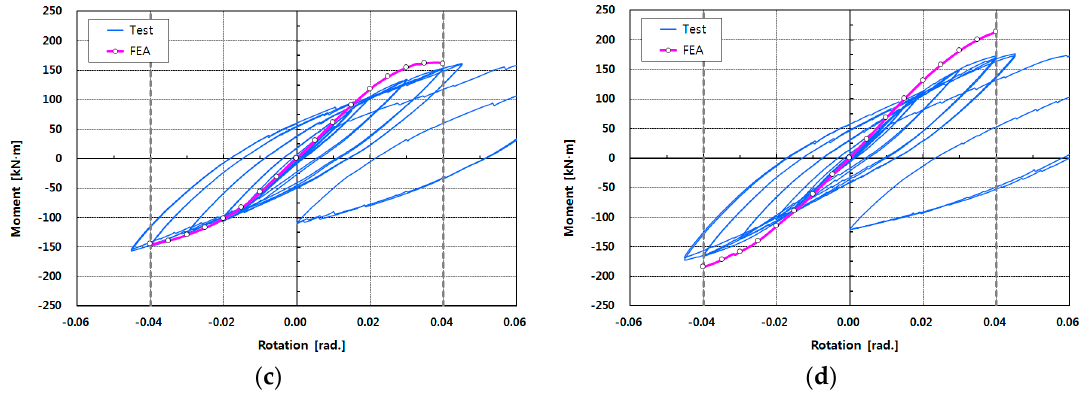
Figure 10. Results of finite element (FE) analysis of specimens: moment–rotation curves. ( a ) C200-W; ( b ) C200-B; ( c ) C100-B; ( d ) L200-B.